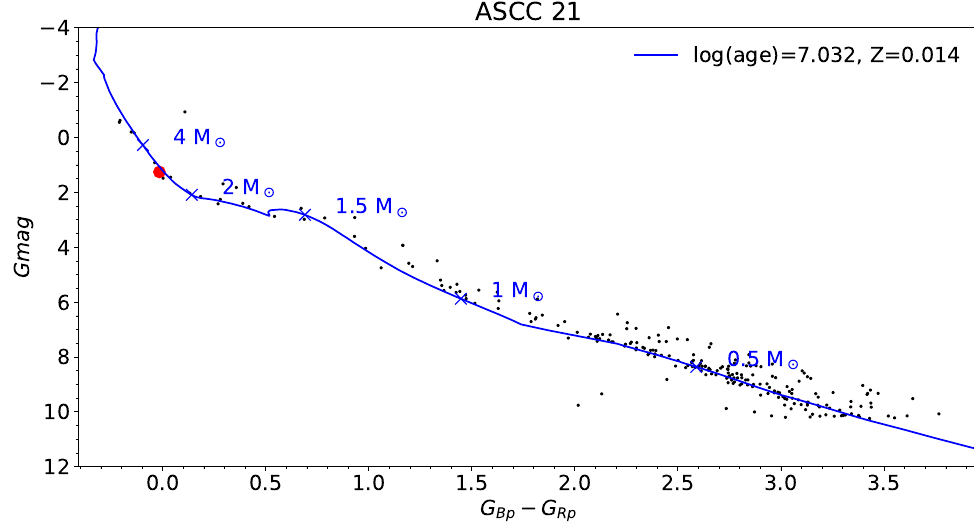
Figure 3. Hertzsprung–Russell diagram for the ASCC21 cluster based on Gaia photometric data and compared with PARSEC isochrones [42] for the solar metallicity Z = 0.014. Age of the cluster (10.8 Myr) is taken from Bossini et al. [43]. Red circle shows the position of HD36030. Lines in the spectrum of HD 36030 clearly display a shift from night to night. We measured radial velocities (RVs) of selected lines (collected in Table 2). For the RV measure- ments, we used Gaussian profile fittings, and, for the case of hydrogen lines, we